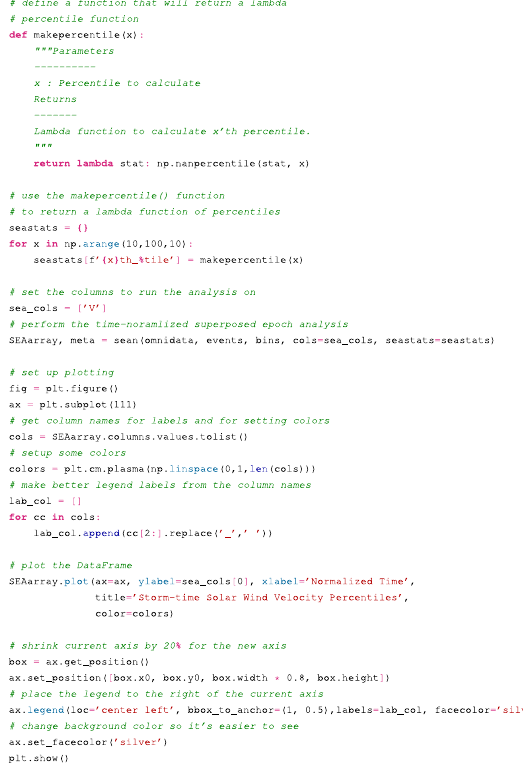
The resulting plot is shown in Figure 3 . All ten deciles are plotted with a color assigned as displayed to the right of the